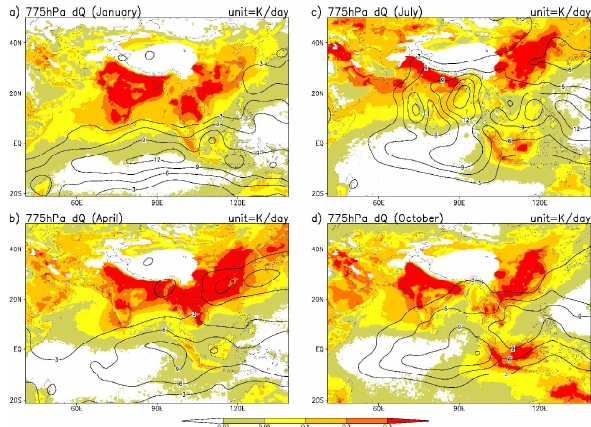
Figure 9. Monthly anthropogenic aerosol radiative forcing averaged from 2001 to 2004. Contours are observed climatological precipitation in units of mm/day. Note that the PNNL model precipitation simulation in this study is similar to the observation in pattern.